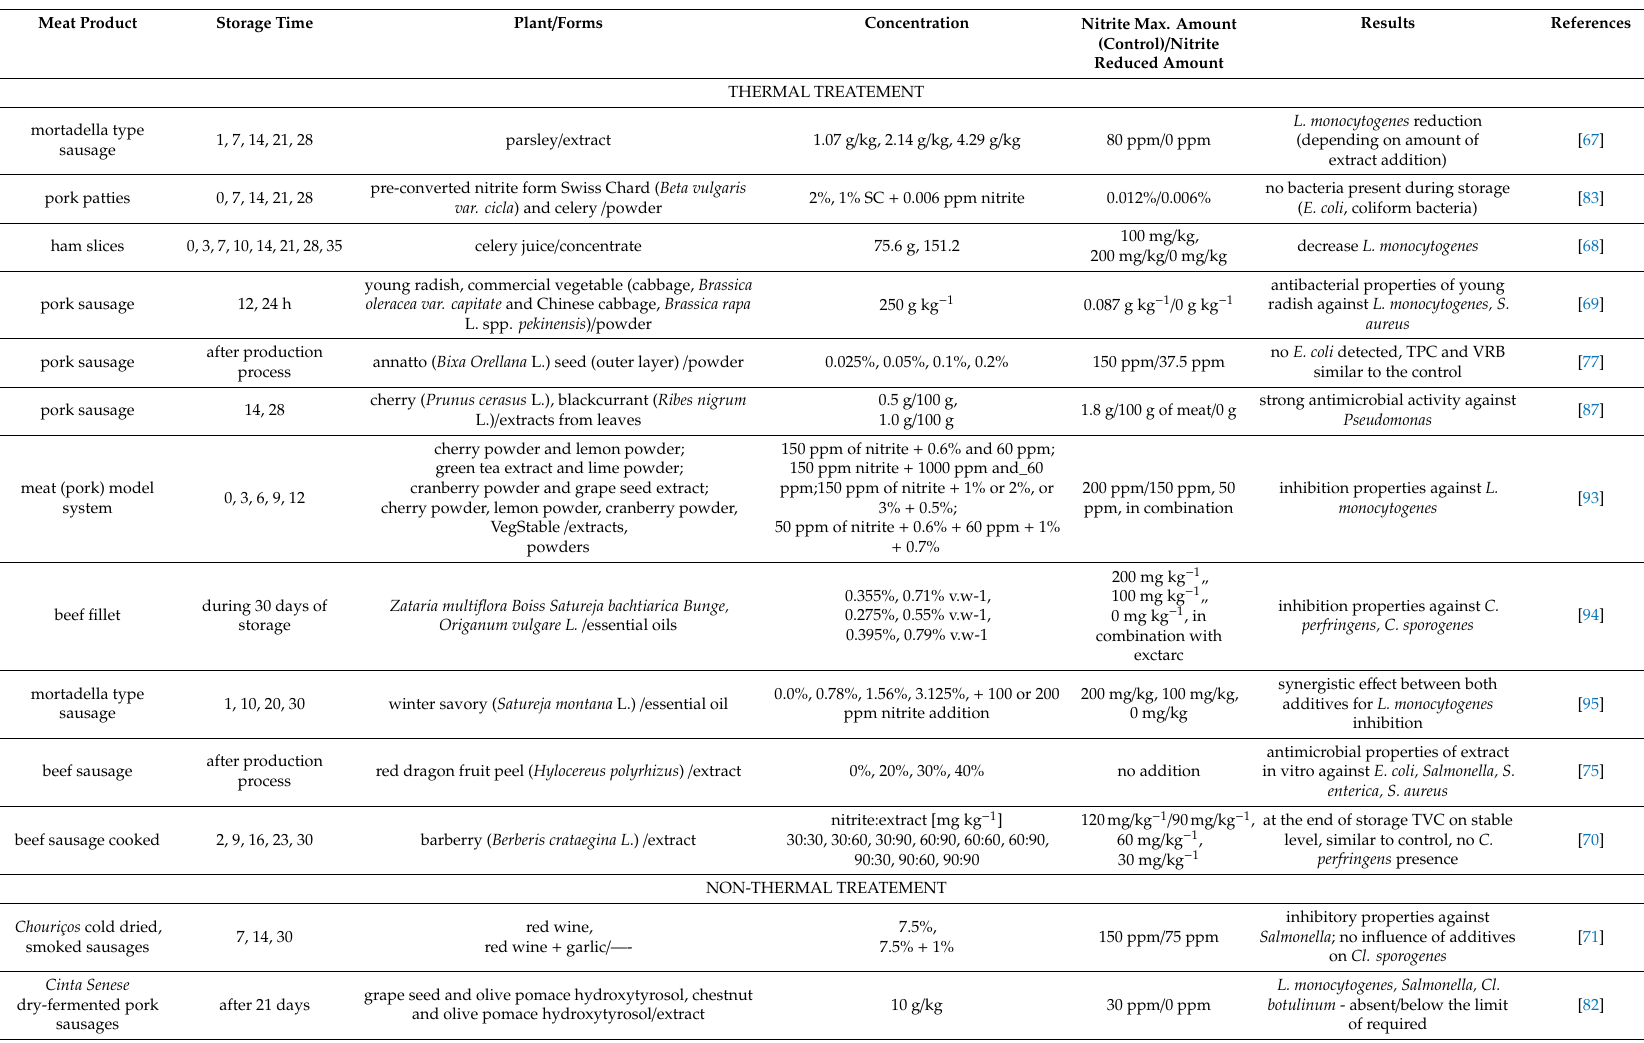
Table 4. Application of plant extracts as natural antimicrobials in meat products with a reduced quantity of